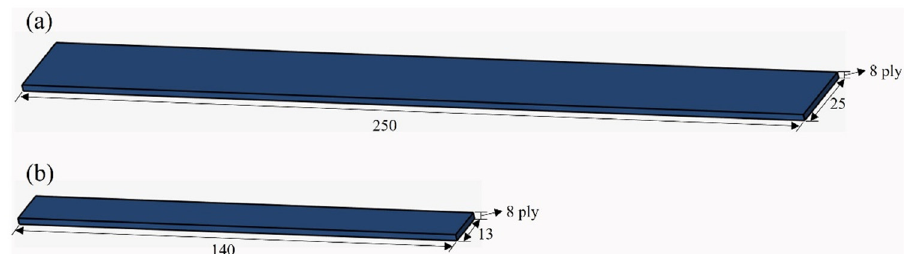
Figure 2: Specimen design: ( a ) tensile and ( b ) compressive test ( Si unit: mm )